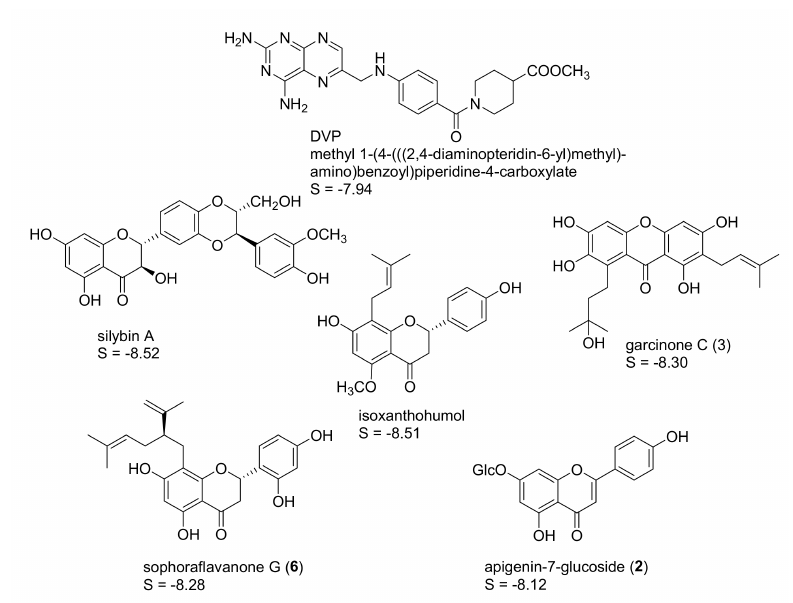
Figure 4. Best five hits from the virtual screening based on the DVP pharmacophore ( Lm PTR1 PDB-ID “3H4V”); S-scores of the induced-fit docking simulations are given in kcal/mol. A “self-docking” computation of the co-crystallized inhibitor DVP was performed